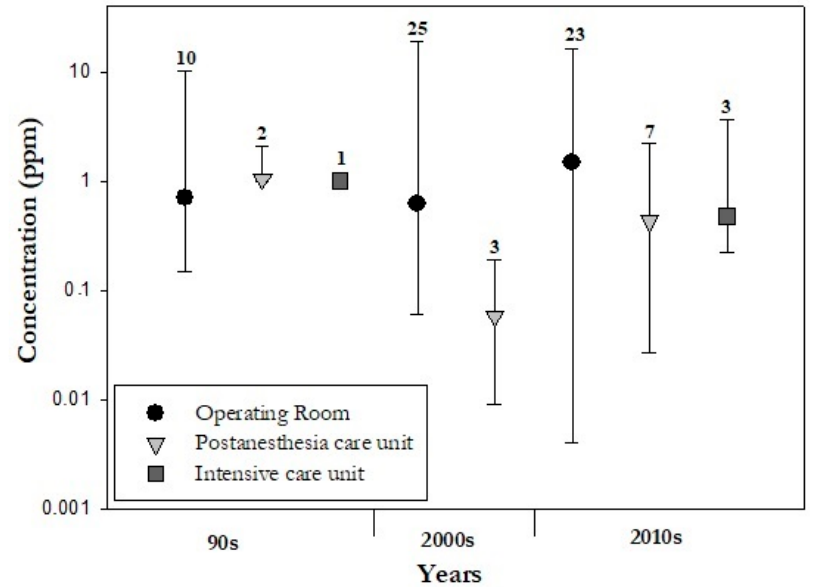
Figure 4. Median (circle, triangle and square), maximum and minimum (error bars) values of all three gases concentrations (sevoflurane, isoflurane and desflurane) in the operating room, post-anesthesia and intensive care units, respectively. Divided in decades (1990s, 2000s, 2010s), number of studies considered per different hospital areas are shown.